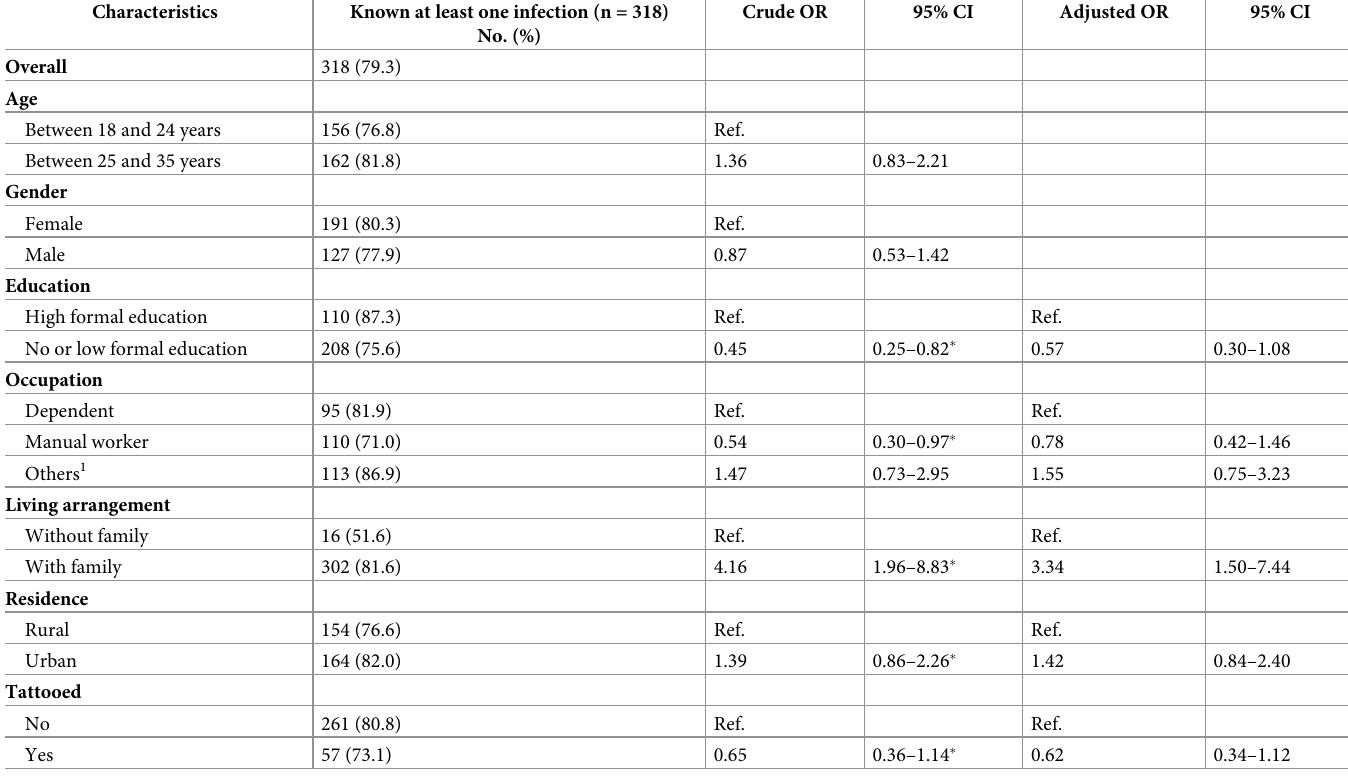
Table 2. Factors associated with knowledge on potential risk of blood-borne viral infections through tattooing, Mandalay Region, 2015 (n = 401).